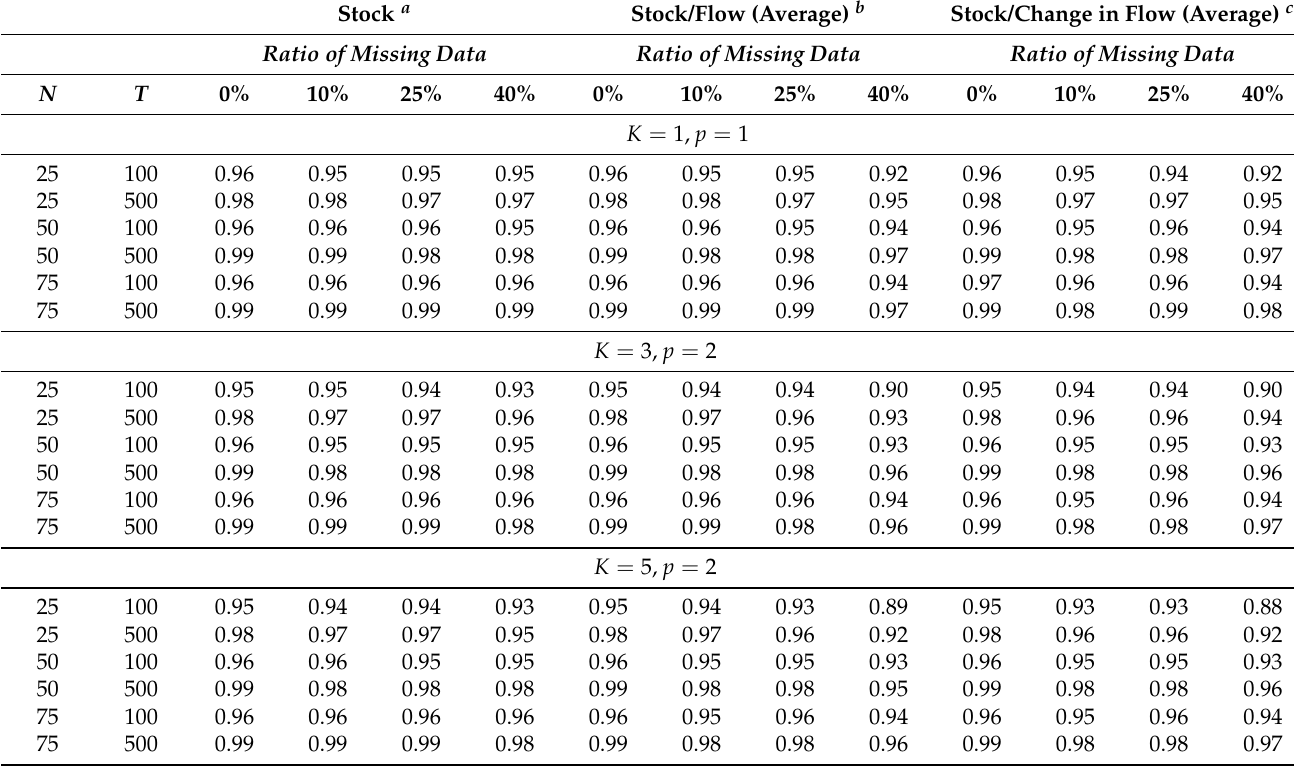
Table A2. Means of trace R 2 for random ADFMs using closed-form factor